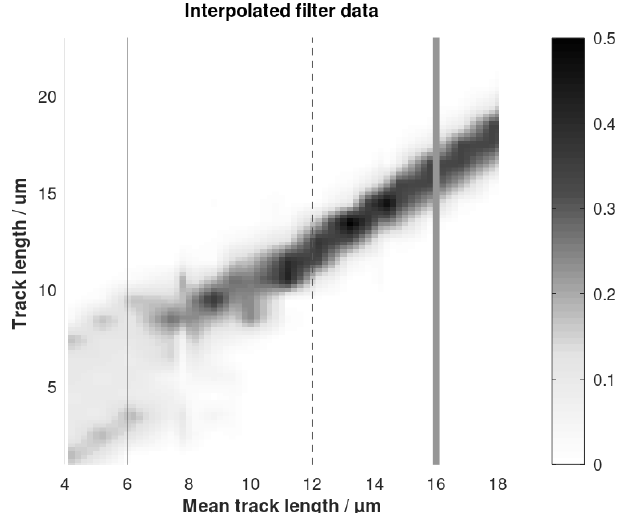
Figure A2. The final step of the deconvolution procedure show- ing the successful deconvolution of the histogram in panel (h) . The histogram in panel (i) is the deconvolved histogram. The degree of success is measured by comparing the convolved histograms in pan- els (g) and (h) .